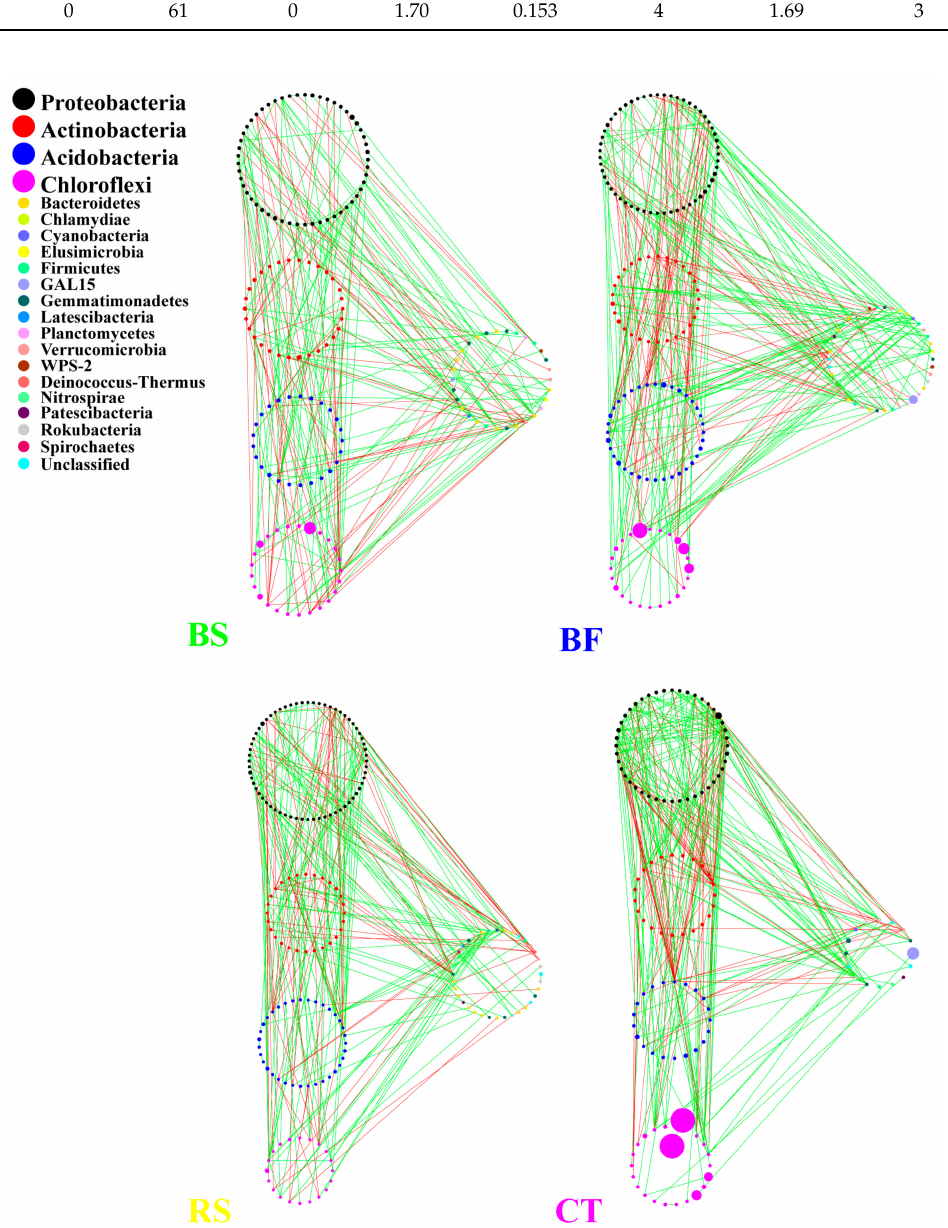
Figure 8. Molecular ecological networks of bacterial communities under different soil and water conservation measures. Green and red lines respectively denote significant positive (Spearman correlation, p < 0.05, r > 0.8) and negative linear (Spearman correlation, p < 0.05, r < − 0.8) relationships. The size of the circles represents the relative abundance of